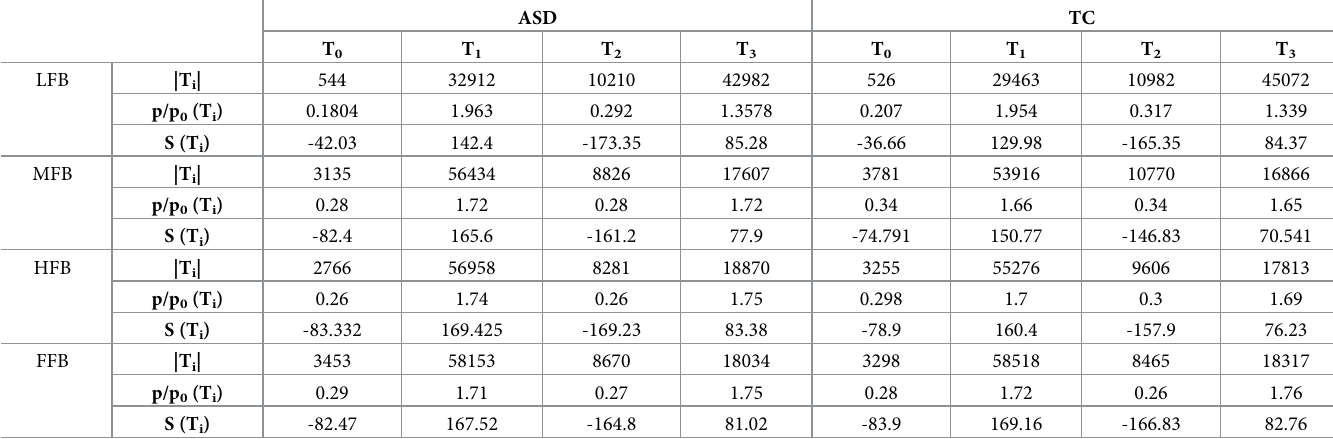
Table 3. The metrics |T i |, S, and the ratio of p/p 0 averaged over subjects. ASD TC T 0 T 1